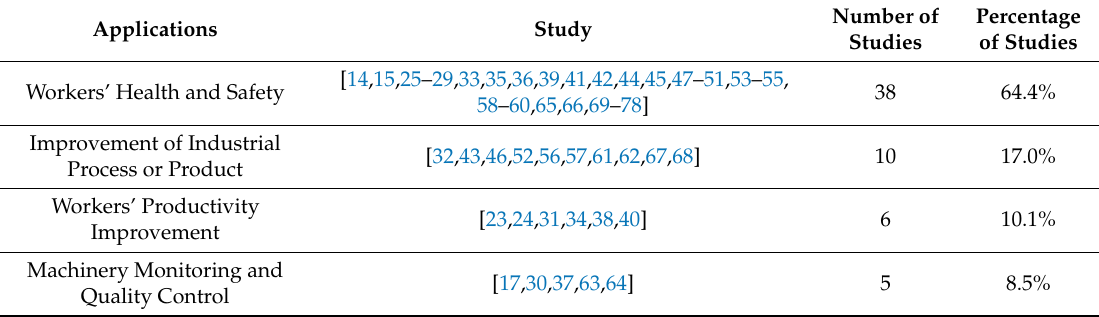
Table 6. Generic MoCap applications in